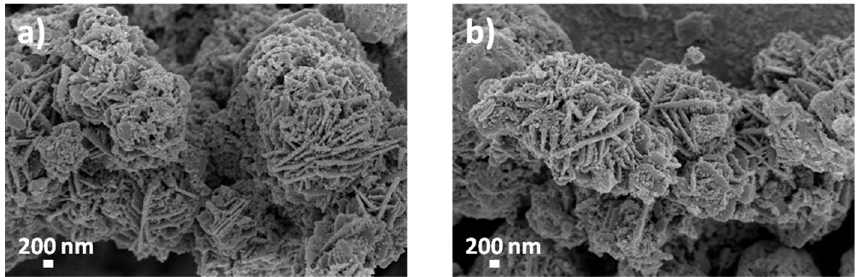
Figure 2. FESEM images showing the flower-like morphology of ZnO microparticle coatings deposited on ( a ) PLA and ( b ) PP polymeric supports.